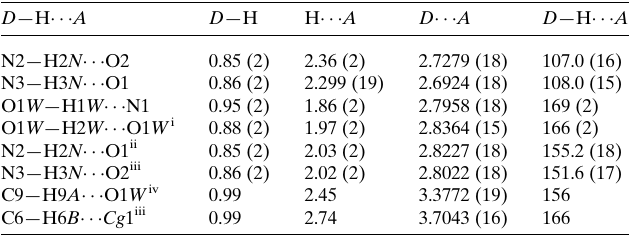
Table 1 Hydrogen-bond geometry (A˚ , (cid:3) ).